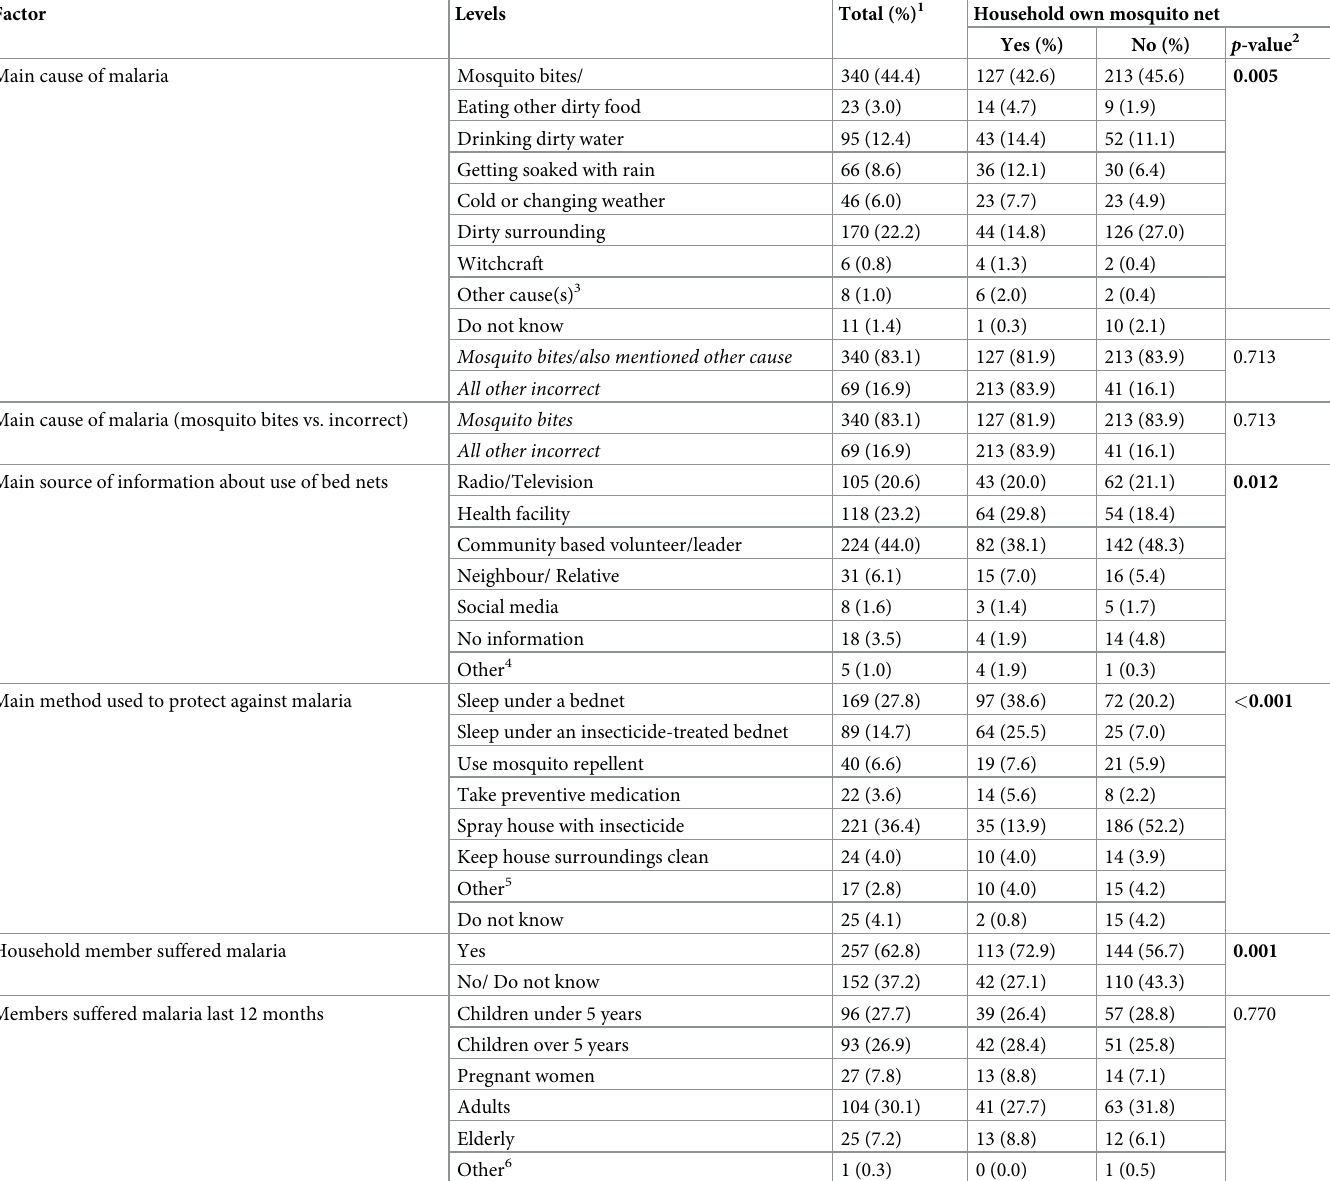
Table 2. Reported knowledge of causes and preventive measures and information about bed nets use among households as reported by the household heads in the Mogadishu districts, Somalia, 2021.